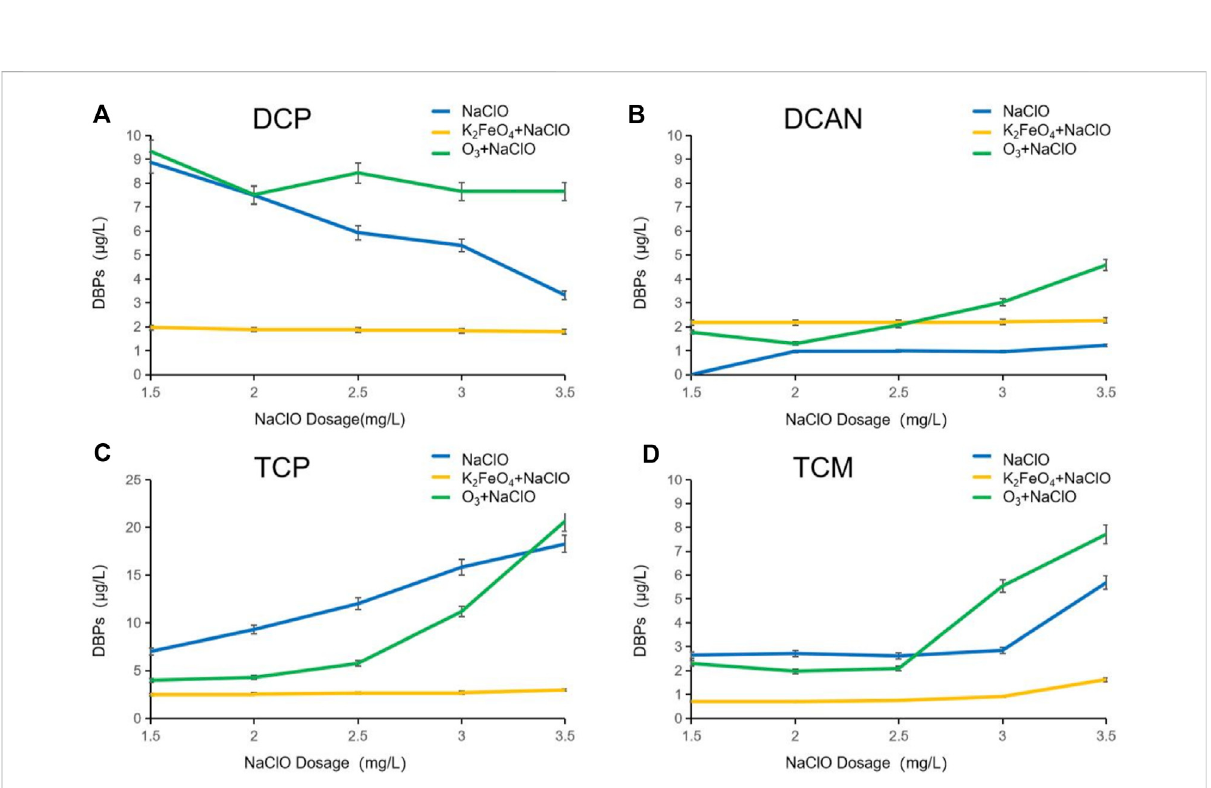
In fl uence of NaClO dosage on DBPs formed after preoxidation of SMZ by K 2 FeO 4 and O 3